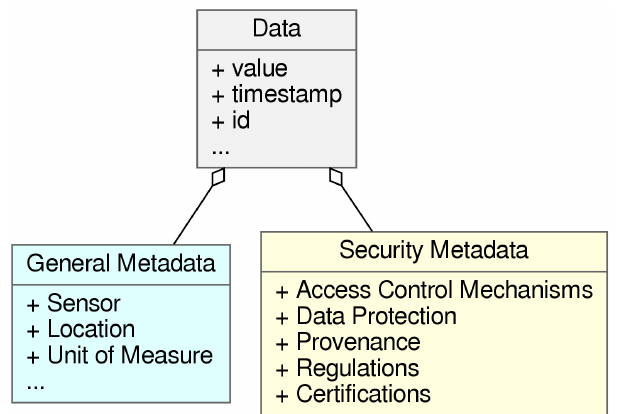
Figure 2. Unified Modeling Language (UML) simile of the data annotation elements related to security, identified in this